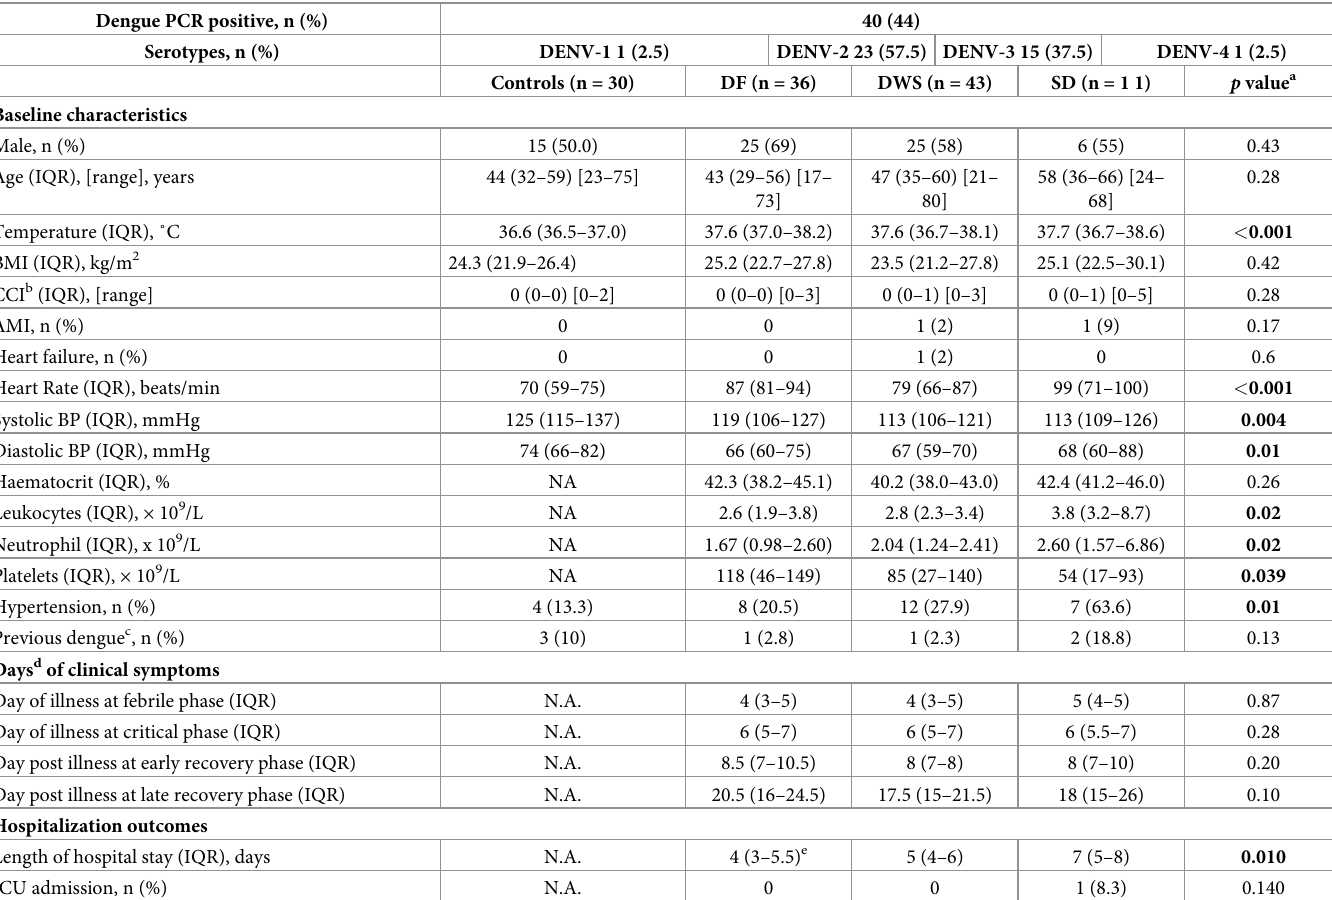
Table 1. Baseline Characteristics of controls, dengue fever, dengue with warning signs and severe dengue patients, and clinical outcomes of dengue participants. Dengue PCR positive, n